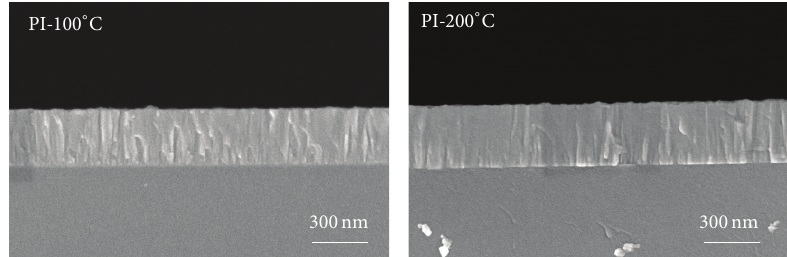
Figure 4: Cross-section observations of the 100 ∘ C- and 200 ∘ C-deposited GZO thin films.